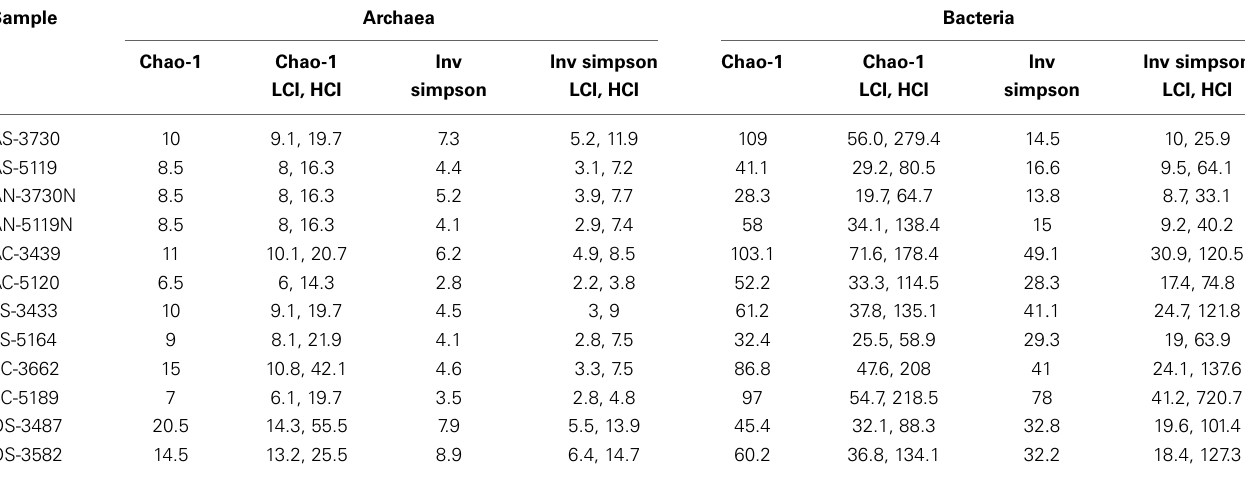
Table 3 | Chao-1 and Inverse Simpson values for Archaeal and Bacterial clone libraries made from each of the 12 samples examined in this